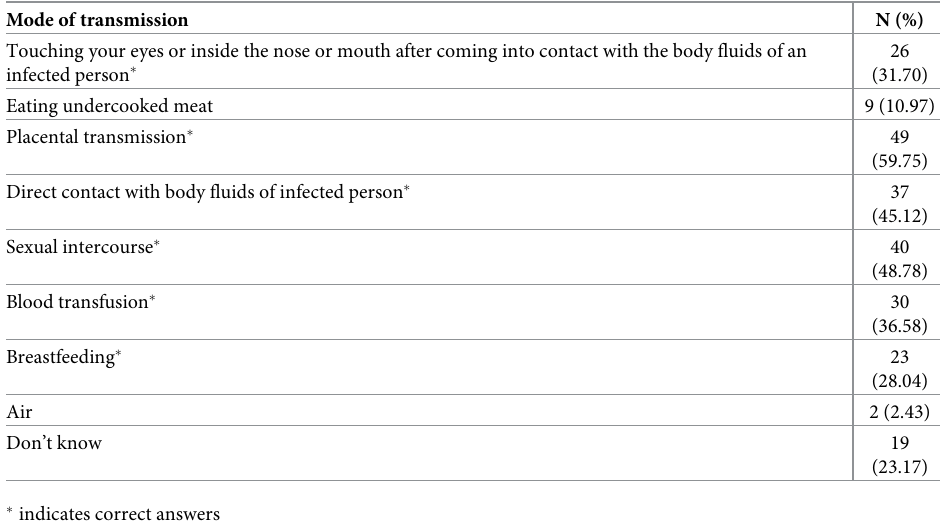
symptoms of CMV whereas 34.76% correctly identified 1–3 correct response, and 23.17% cor- rectly identified 4–7 correct responses (Table 3). In terms of specific CMV-associated symp- toms, women with knowledge of CMV correctly identified death (n = 31, 37.80%), mental retardation (n = 28, 34.14%), hearing loss (n = 20, 24.39%), petechiae (n = 17, 20.73%), micro- cephaly (n = 18, 21.95%), vision problems (n = 15, 18.29%), hepatomegaly (n = 26, 31.70%), and splenomegaly (n = 21, 25.60%) as CMV-associated symptoms, while 6 (7.31%) and 9 (10.97%) women incorrectly identified cancer and heart defects, respectively as symptoms of CMV (Table 3).